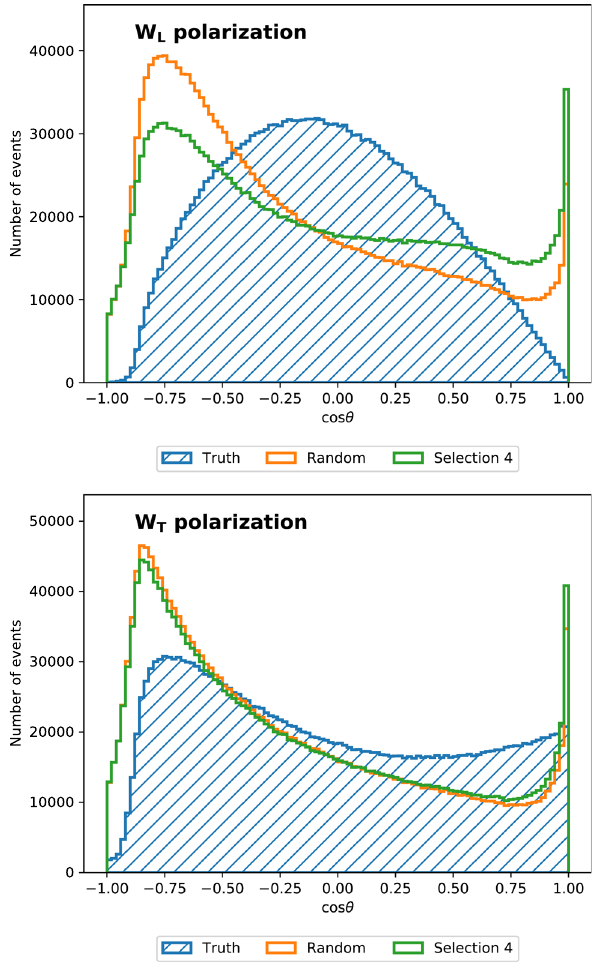
Fig. 6 MAOS reconstructed inclusive lepton (electron and muon) angular distribution in the W boson rest frame, compared to true par- ton level distribution, in the fully-leptonic channel. The top plot shows the purely longitudinal (W L ) and the bottom plot the purely transverse (W T ) scenario. Longitudinal neutrino momenta are calculated from the W mass constraint, using random solution and selection 4 strategies, described in Sect. 4.2. Truth distributions use the generator-level (true) cos